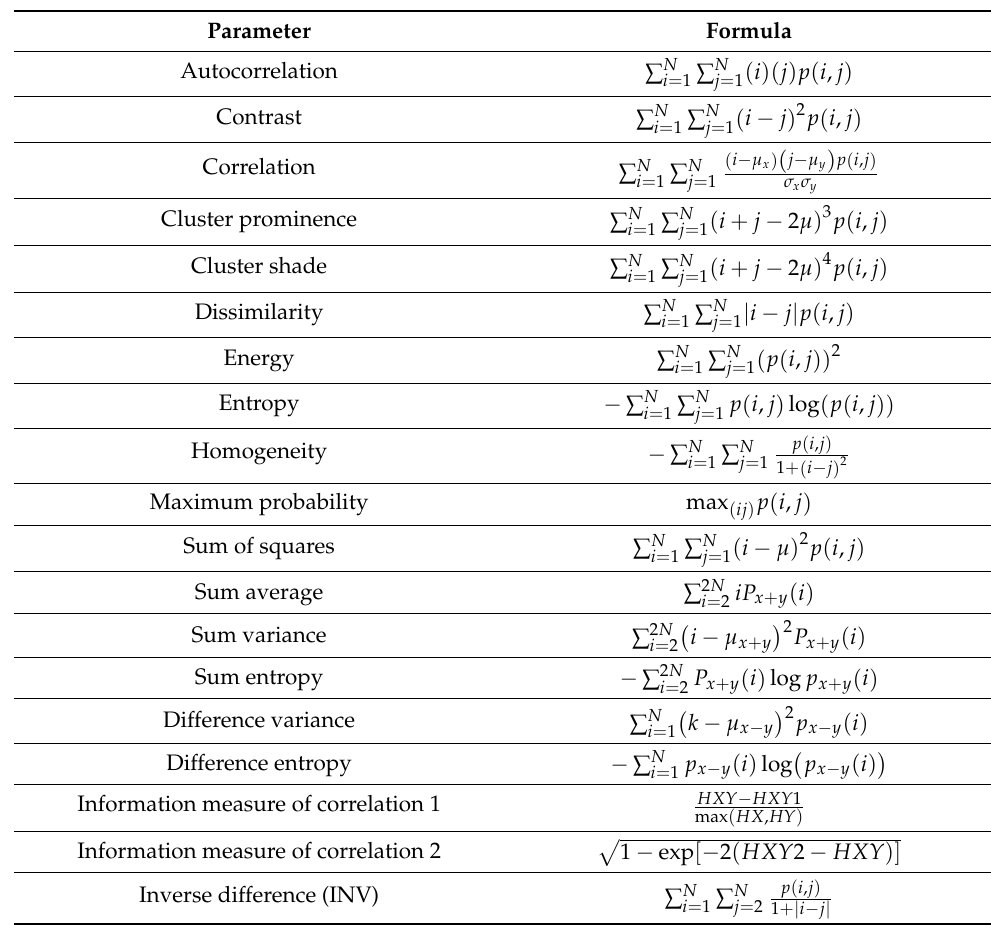
Figure 6. The results of preprocessing: ( a ) histogram equalization; ( b ) range filter.